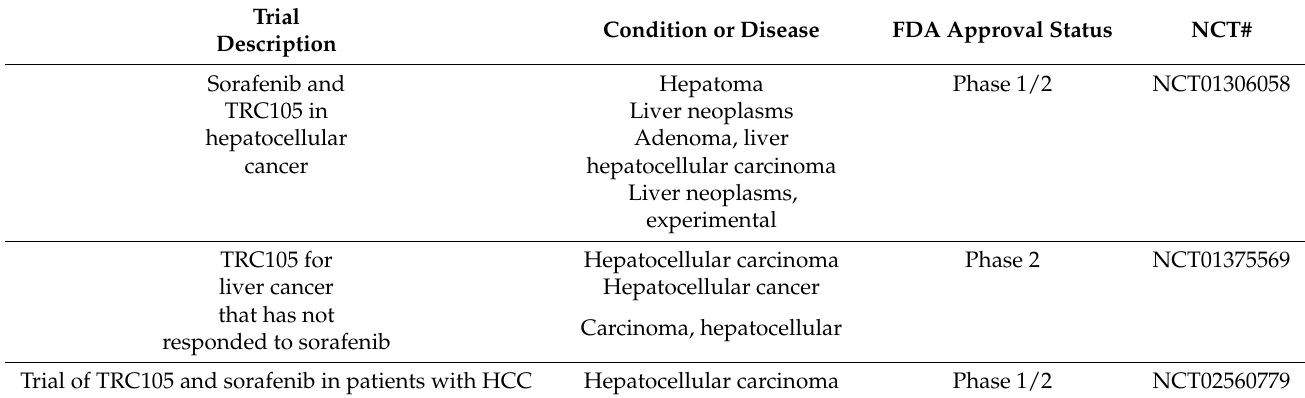
Table 1. Clinical trials of carotuximab (TRC105) use against liver